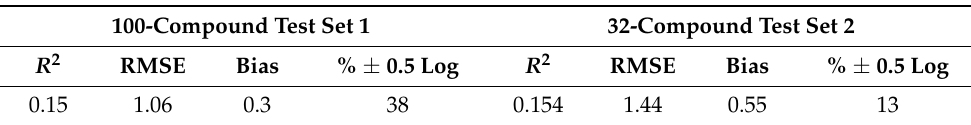
Table 8. Statistical measures of prediction performances obtained on SC-2 test sets with ANN using alternative descriptors for ALOGP.